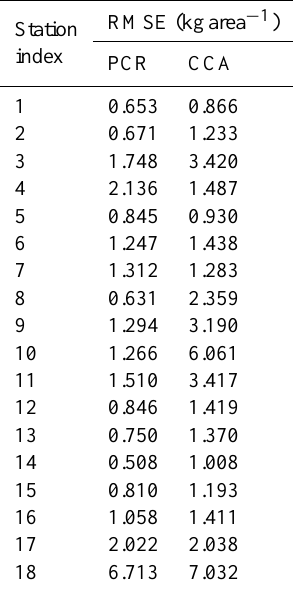
Table 6. RMSE (Eq. 4) of forecasted TN loadings based on PCR and CCA models that consider ECHAM4.5 precipitation forecasts and December streamflow as predictors under